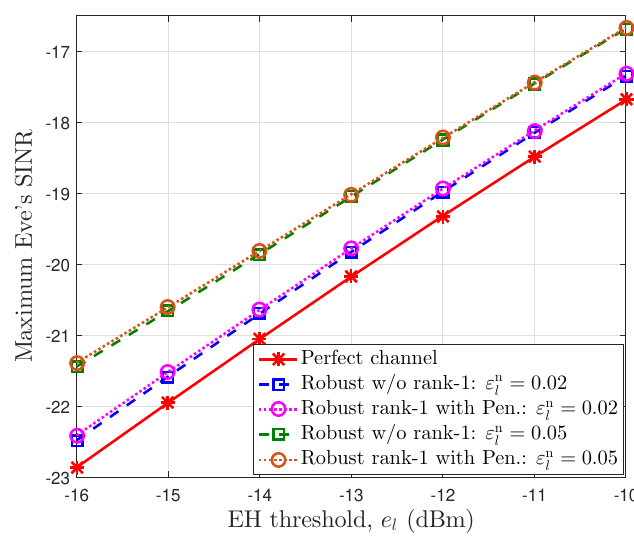
Figure 5. The maximum Eve’s SINR according to the EH threshold at the users.